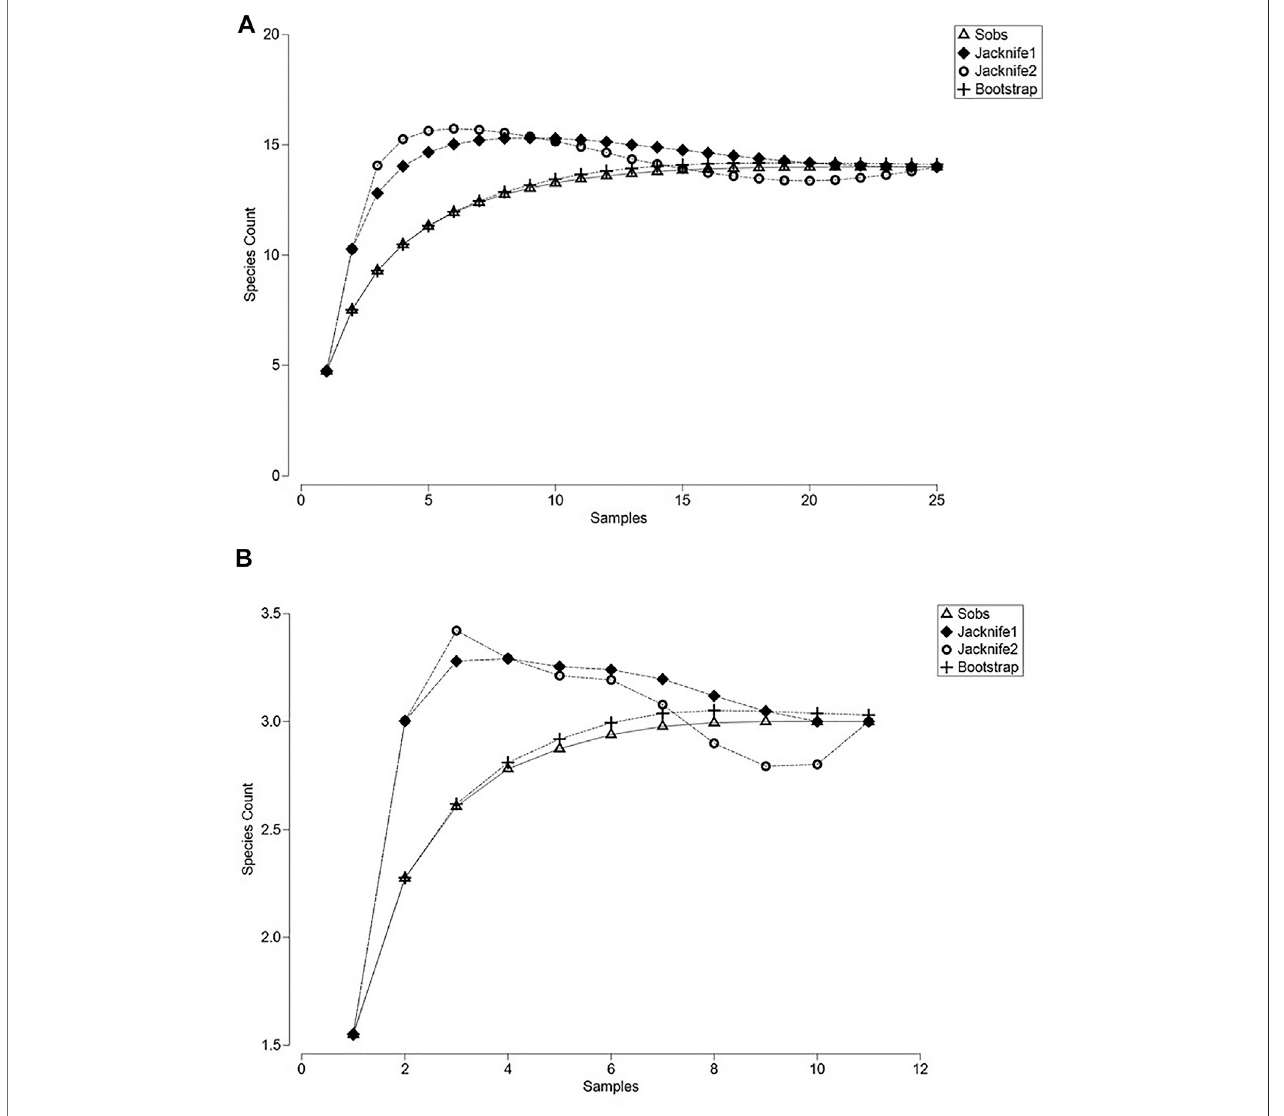
FIGURE 1 | Species accumulation curves of anurans found in larval stage in water bodies in tropical fl ooded savanna of the Yopal Municipality (Casanare Department, Colombia). (A) Species accumulation curves of tadpoles in natural ponds. (B) Species accumulation curves of tadpoles in anthropogenic puddles.